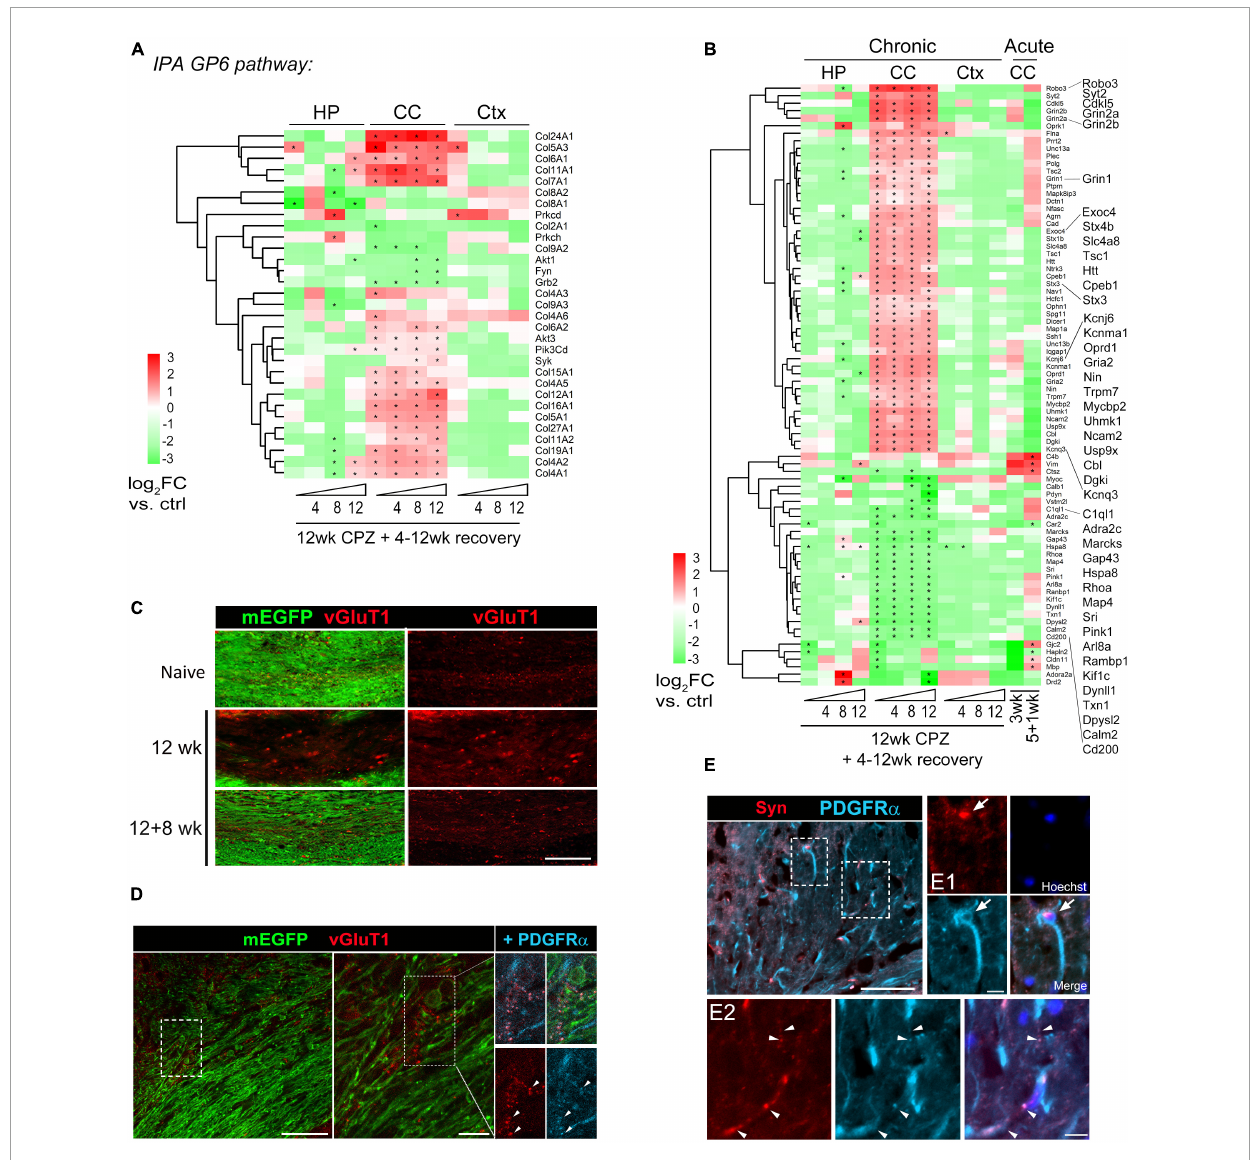
FIGURE5 Activation of GP6/collagen and synaptogenesis pathways in corpus callosum during chronic demyelination and recovery. (A) Heatmap of 31 DEGs functioning in the GP6 pathway identified by IPA as the most significantly altered pathway in the corpus callosum. Region- and time-point comparison of the 31 DEGs over normal controls is shown. Asterisks indicate significant DEGs ( q < 0.05) in comparison to controls. (B) Axon gene ontology (GO0030424: 765 genes) was applied to the Deseq dataset and Log2FC Heatmap of top 80 DEGs during acute and chronic demyelination and remyelination is shown. Asterisks, significant DEGs in comparison to controls (q < 0.05). (C) Representative vGluT1 staining of the medial corpus callosum of control mice and mice treated with cuprizone for 12 weeks followed by 8 weeks of recovery. Scale bar, 100 µ m. (D) Representative confocal image of lateral corpus callosum from CNP-mEGFP mice fed cuprizone for 12 weeks. The boxed regions are zoomed-in on the right. Scale bars, 50 µ m (left), 10 µ m (right). (E) Representative synaptophysin (Syn) and PDGFR α double immunostaining images of corpus callosum sections from 12 wk cuprizone mice. Scale bar, 50 µ m. Boxed regions are shown in higher magnification in panels (E1,E2). Arrows indicate a Syn + OPC and arrowheads indicate overlapping synaptophysin and PDGFR α immunoreactivity. Scale bars, 10 µ m